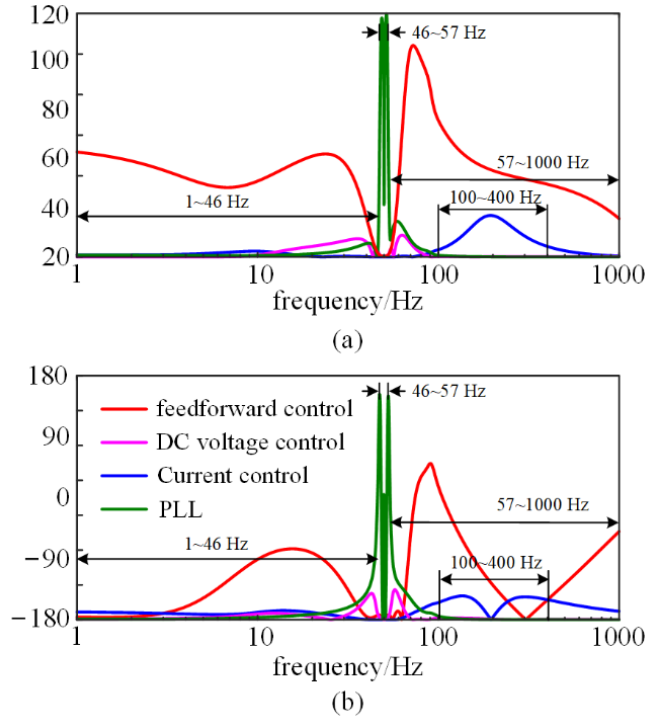
Figure 3. Impacts of DC voltage controller on MMC-HVDC impedance characteristic. ( a ) impedance magnitude sensitivity; ( b ) impedance phase sensitivity.